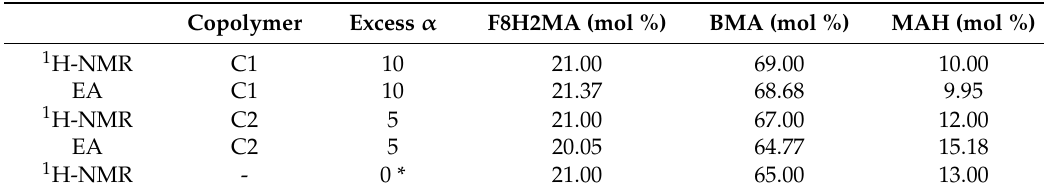
Table 7. Copolymer composition calculated from 1 H NMR and elemental analysis (EA) at different monomer excess and low conversion experiment ( α =